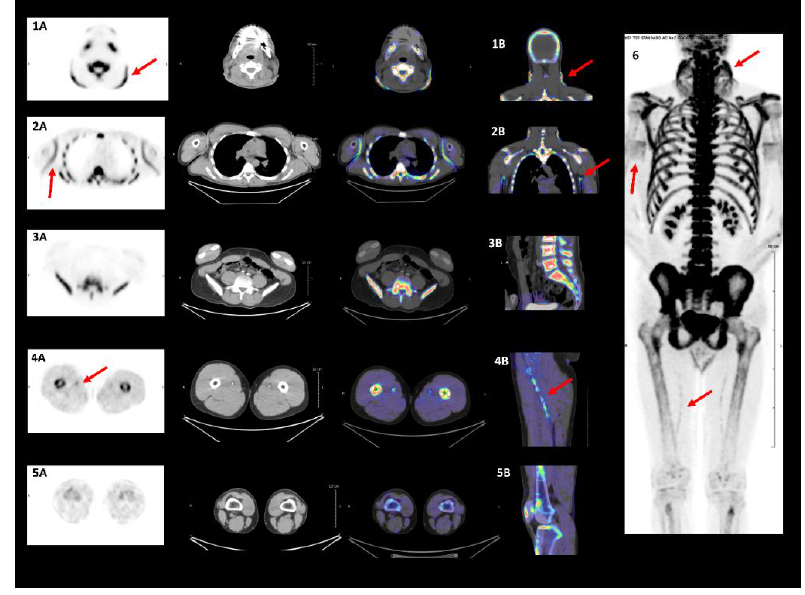
Figure 3. 18F-NaF uptake in specific damaged skin/arteries in PXE . Damaged skin in neck (arrows ( 1A , 1B )) and axillary folds (arrows ( 2A , 2B )) vs healthy skin in lumbar region ( 3A , 3B ) on PET/CT imaging. Molecular calcification targeted with 18F-NaF. Damaged femoral arteries on PET/CT imaging. Molecular calcification targeted via PET/CT demonstrating 18F-NaF femoral arteries wall uptake (arrows ( 4A , 4B )). 18F-NaF uptake absent in popliteal arteries walls ( 5A , 5B ). Maximum intensity projection indicates damaged vascular and skin sites (arrow 6).